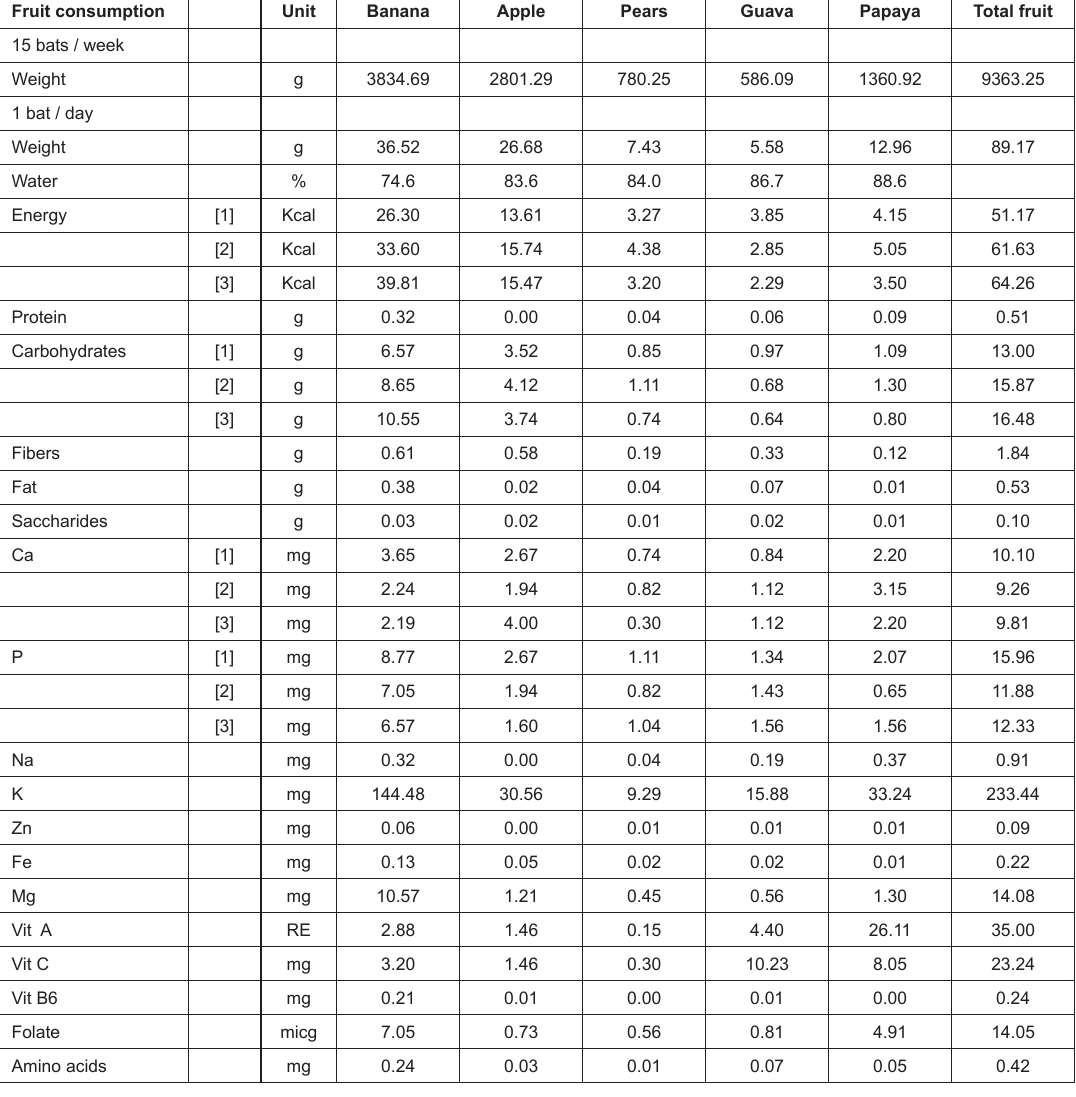
Table 1. Nutritional value of average fruits consumed by C. sphinx in captivity